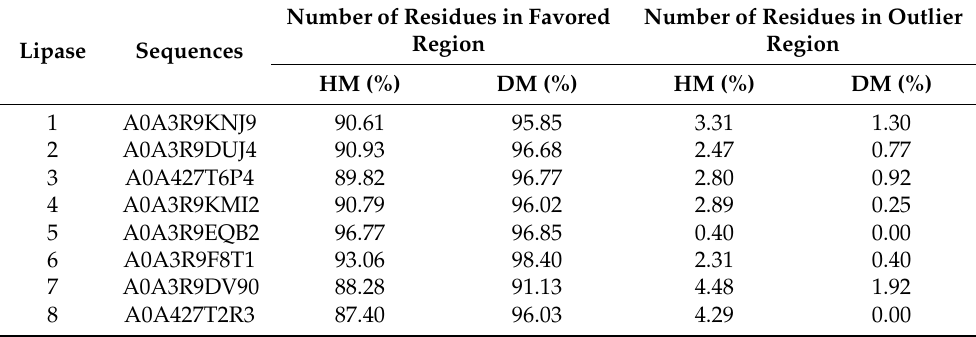
Table 3. Ramachandran plot information for the 3-D structures of lipases (HM = Homology Modeling, DM = Deep learning de novo Modeling).